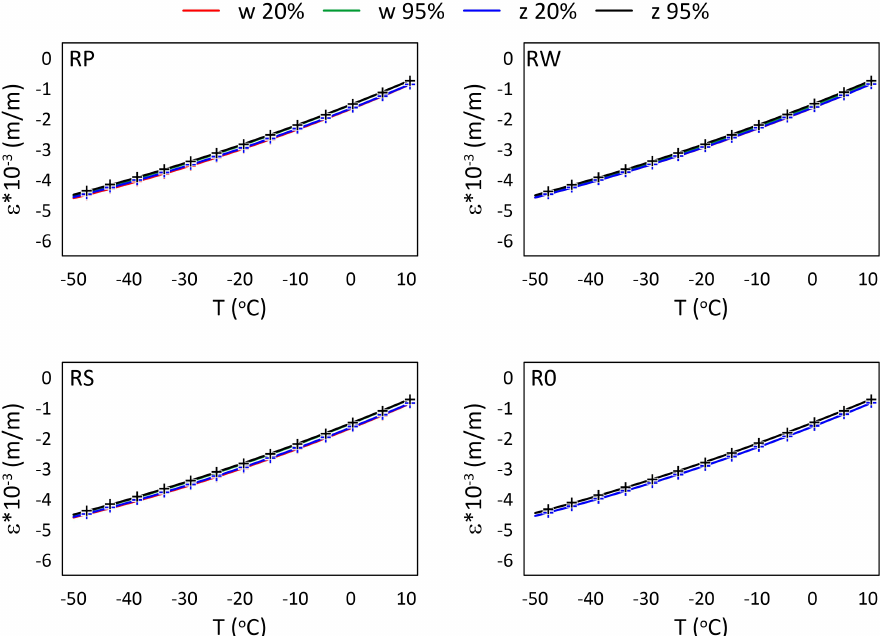
Figure 10. Strain for M3 X samples under sub-zero temperatures and selected RH (20%, 95%) levels; crosses—measured values, continuous line—approximation.